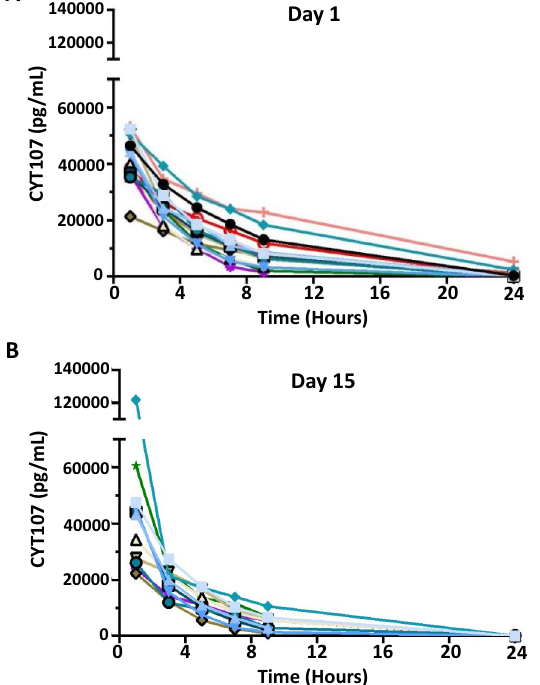
Fig. 2 CYT107 Pharmacokinetics. Concentration of CYT107 was measured in patients’ plasma at 1, 3, 5, 7, 9 and 24 h after intravenous administration. Values reported are the pharmacokinetics results for each patient who received CYT 107 at day 1 in A n B n =